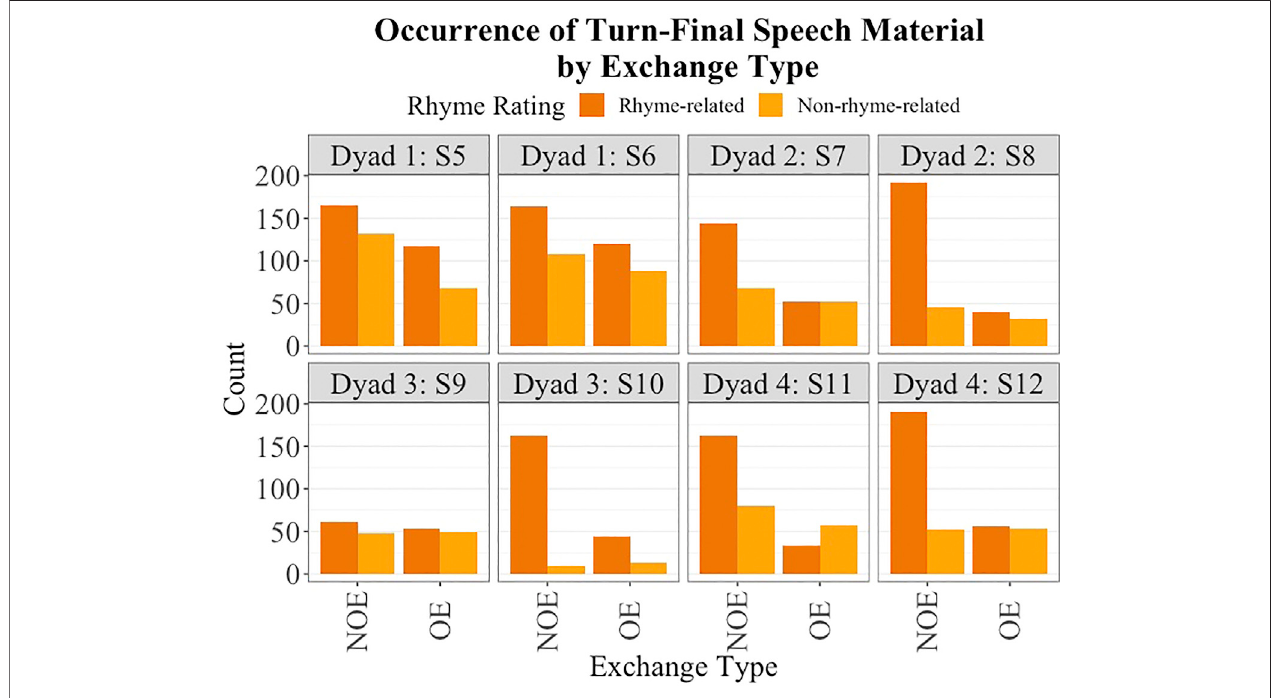
FIGURE 5 | Count of speech content occurrence by exchange type by